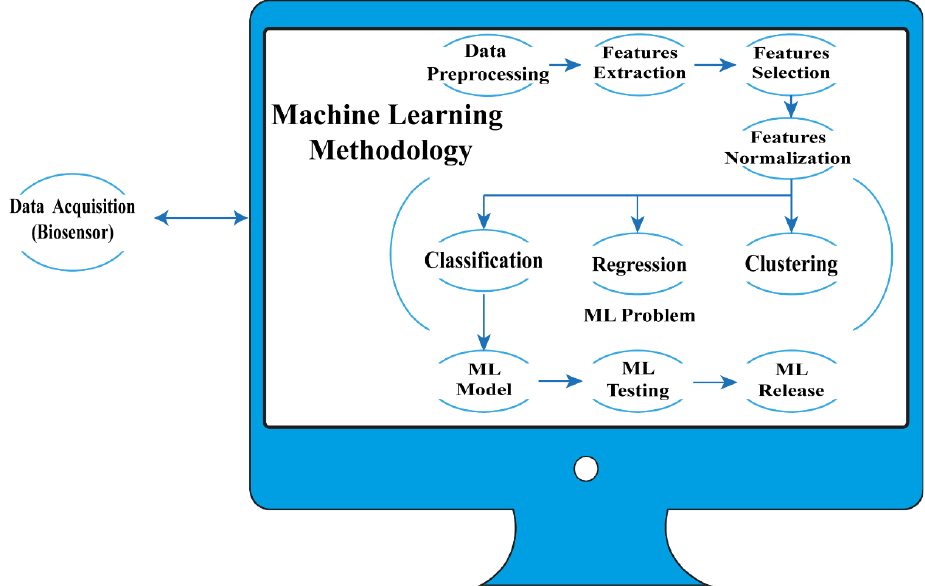
Figure 1. Biosensors assisted by